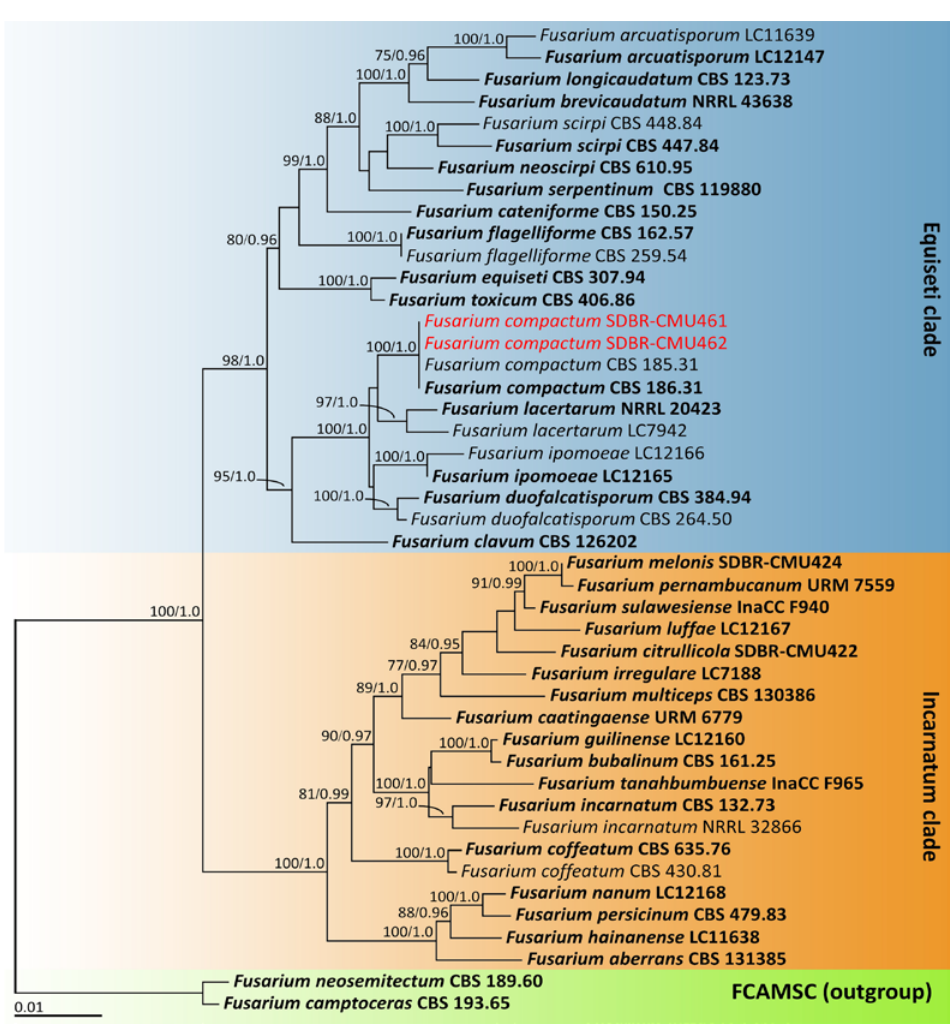
Figure 2. Phylogenetic tree derived from maximum likelihood analysis of Fusarium incarnatum-equiseti species complex of the combined tef-1 , cam and rpb2 sequences of 45 taxa. The outgroup included F. camptoceras CBS 193.65 and F. neosemitectum CBS 189.60. Numbers above branches are the bootstrap percentages (left) and Bayesian posterior probabilities (right). Branches with bootstrap and Bayesian posterior probabilities values greater than or equal to 75% and 0.95, respectively, are shown at each branch. The scale bar displays the expected number of nucleotide substitutions per site. The sequences of the fungal species derived in this study are shown in red. Type species are shown in bold.